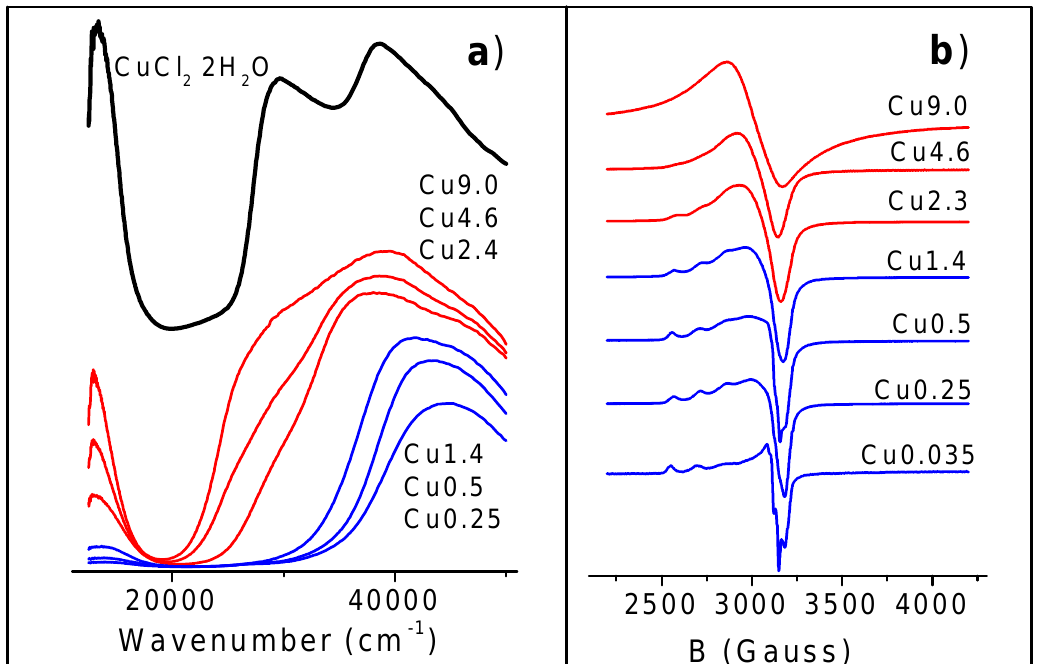
Figure 2: Part (a) UV-Vis DRS spectra of from top to bottom: CuCl Cu2.3 (red) Cu1.4, Cu0.5 and Cu0.25 (blue). Part (b): LNT EPR spectra of all samples. Cu content in- creases, from bottom to top. The amplitude of the EPR signal of all samples has been multiplied by different factors for graphical